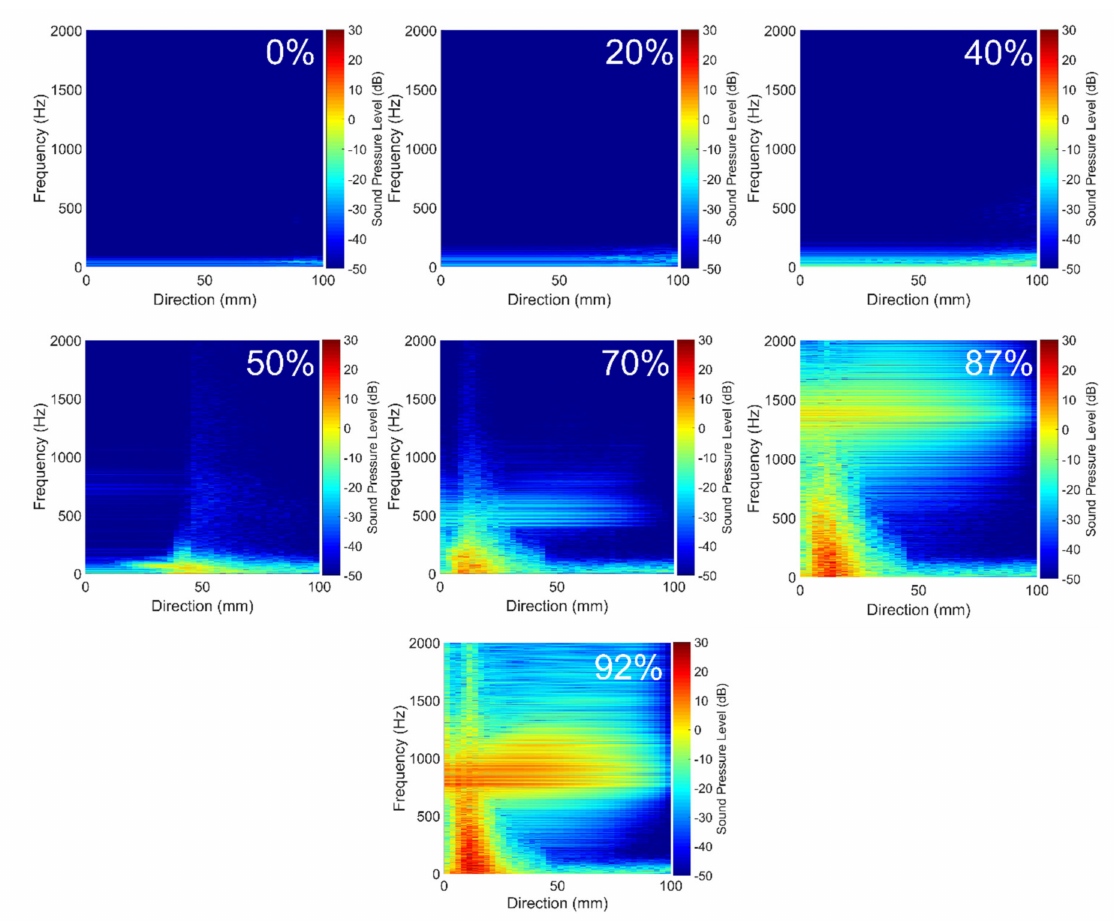
Figure 9. Acoustic spatial-frequency map of the post-stenotic region for all severity